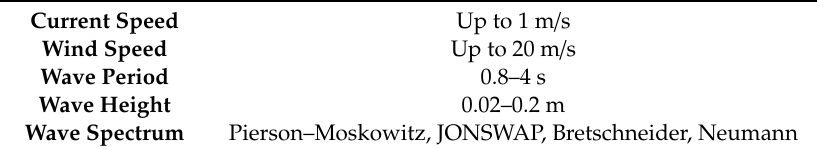
Table 5. Testing capabilities of the wind–wave–current